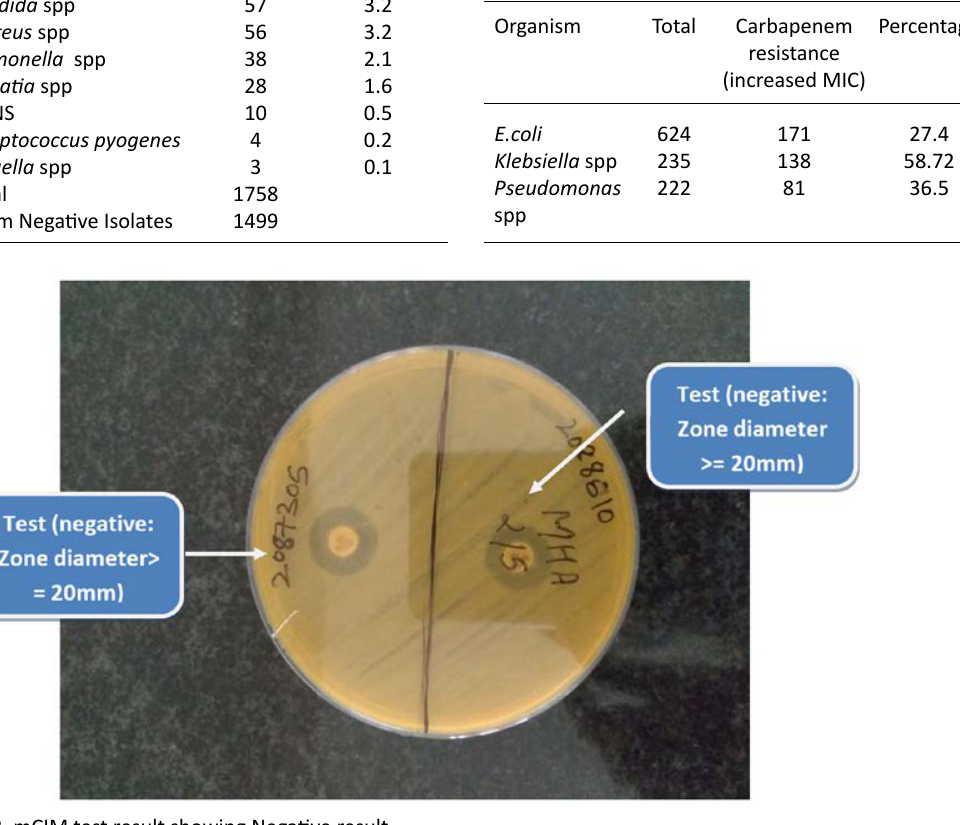
Fig. 2. mCIM test result showing Negative